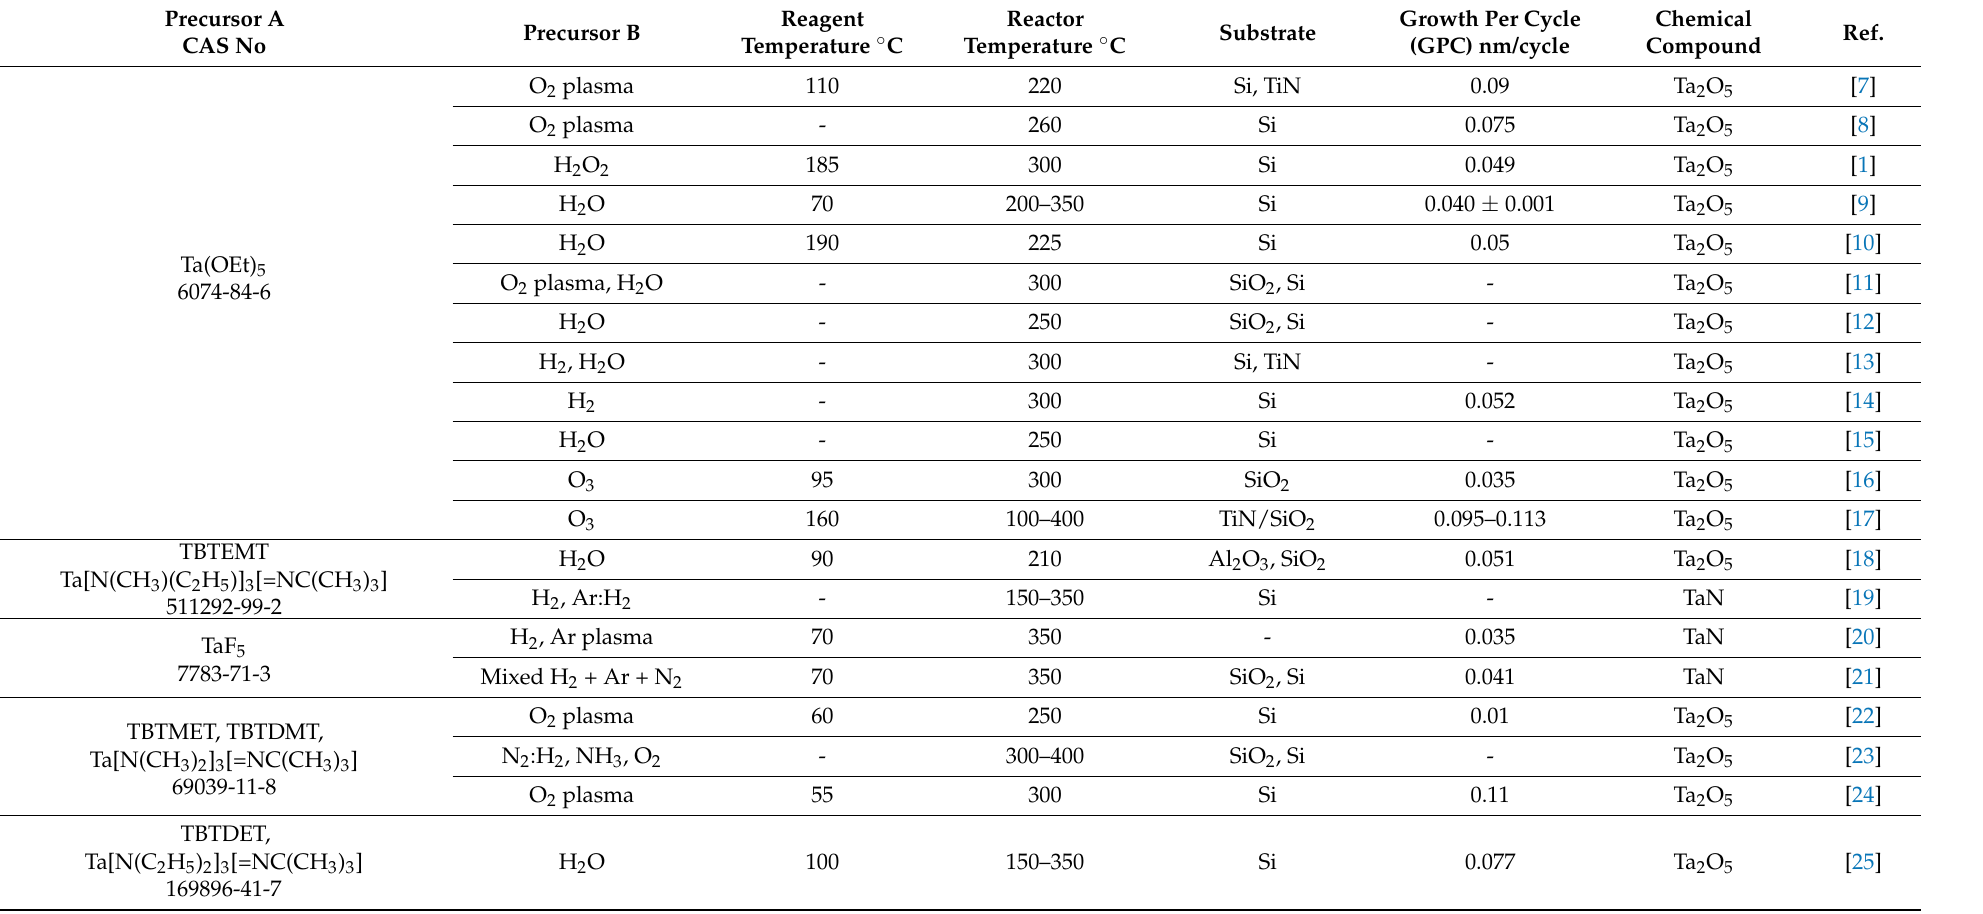
Table 1. Comparative characteristics of the tantalum binary compounds obtaining processes by the ALD